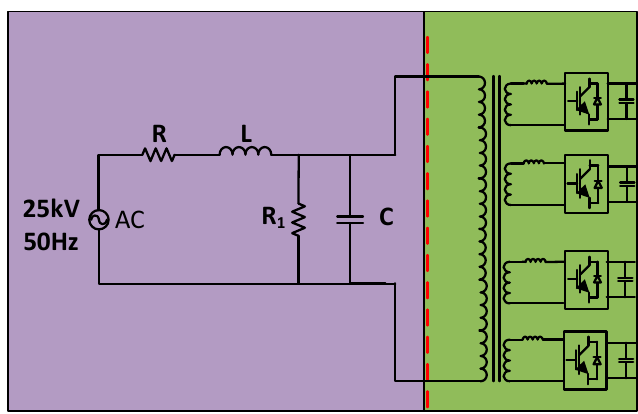
Figure 19. Diagram of grid–train coupling simulation.